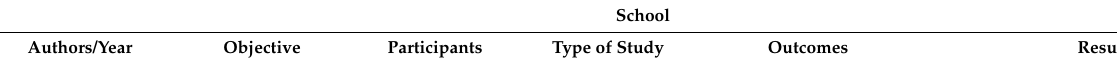
Table A3. Characteristics and main results of the studies